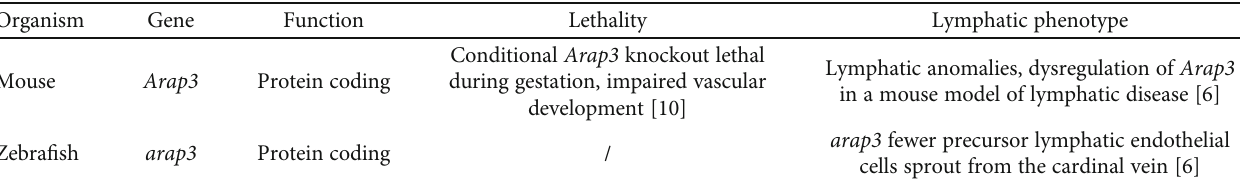
Table 1: Phenotype associated with the Arap3 gene in di ff erent